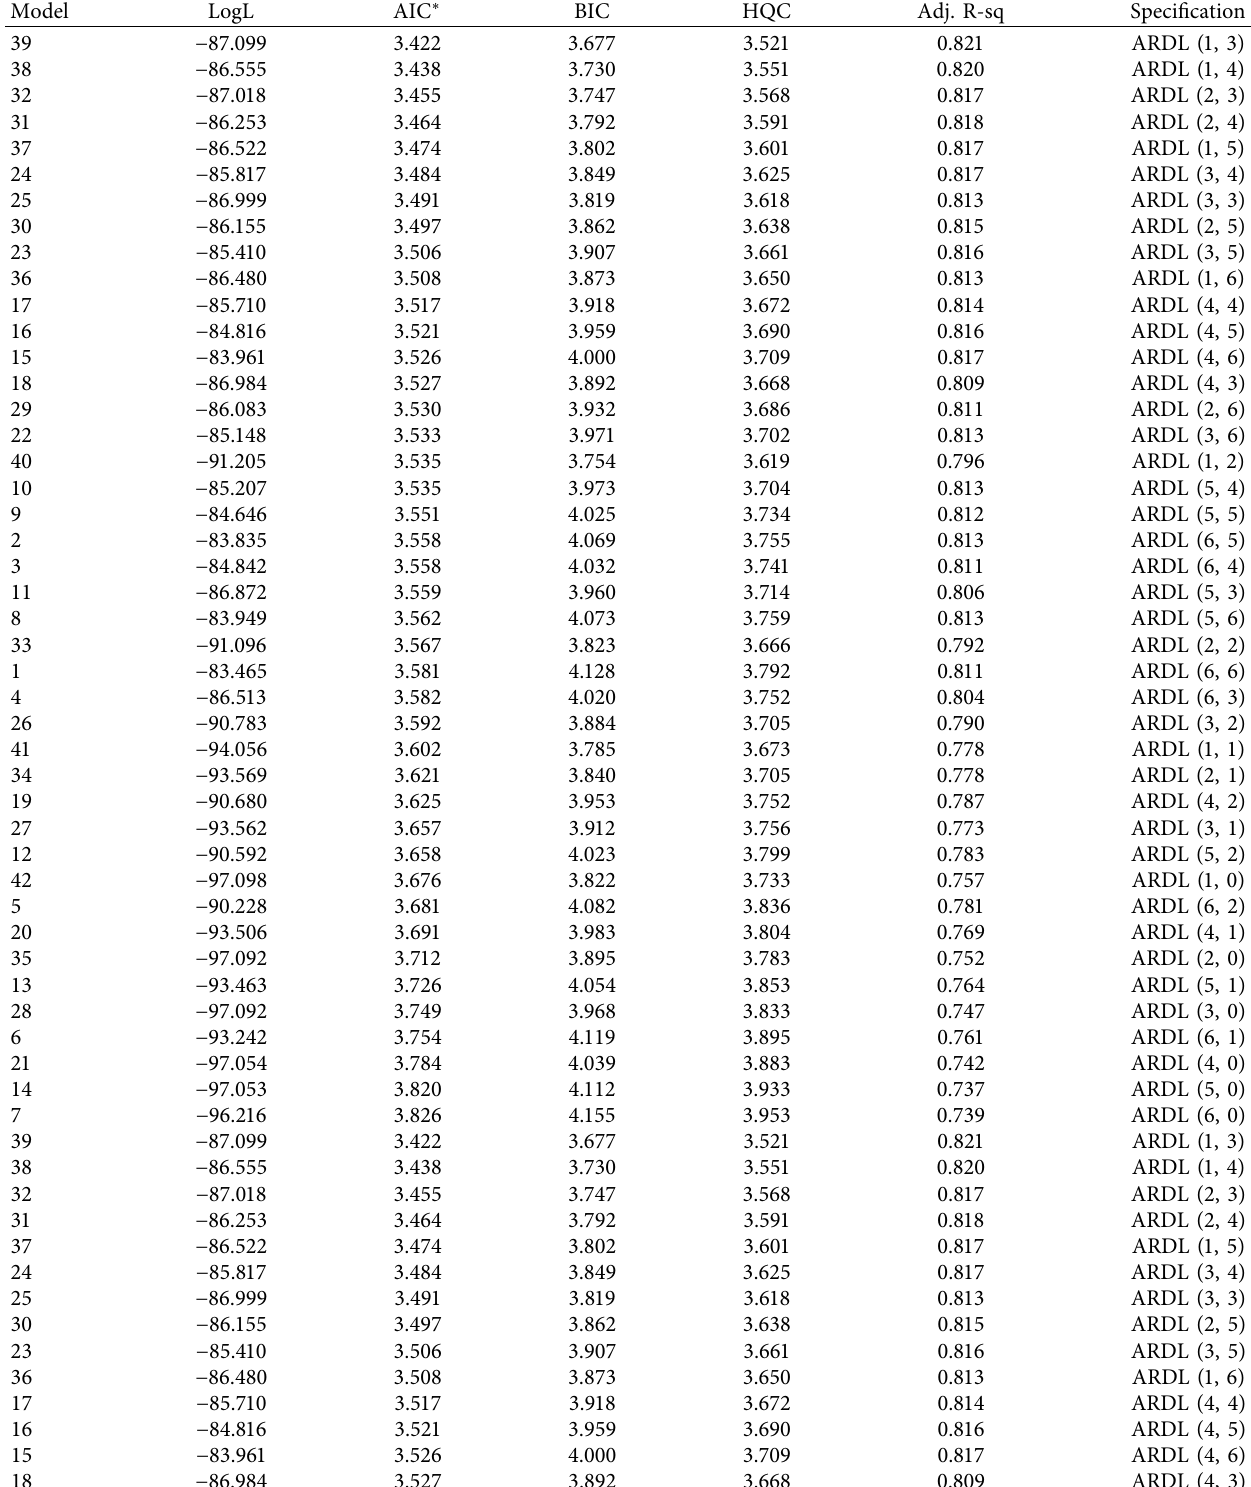
Table 4: Selection of model lag